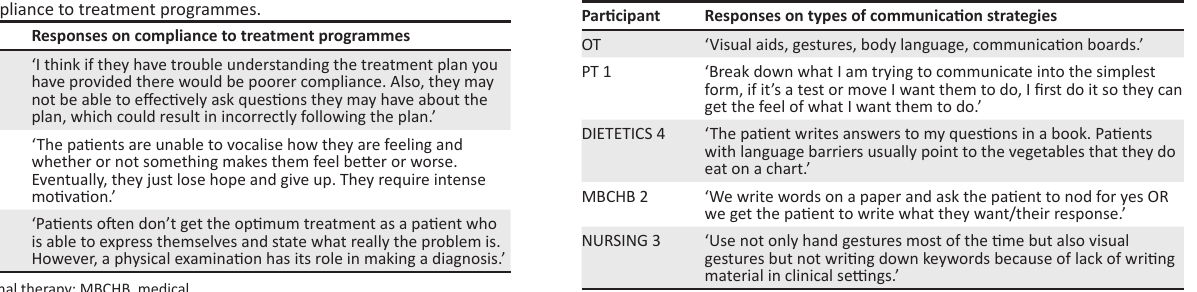
TABLE 6: Participants’ responses on the types of communication strategies